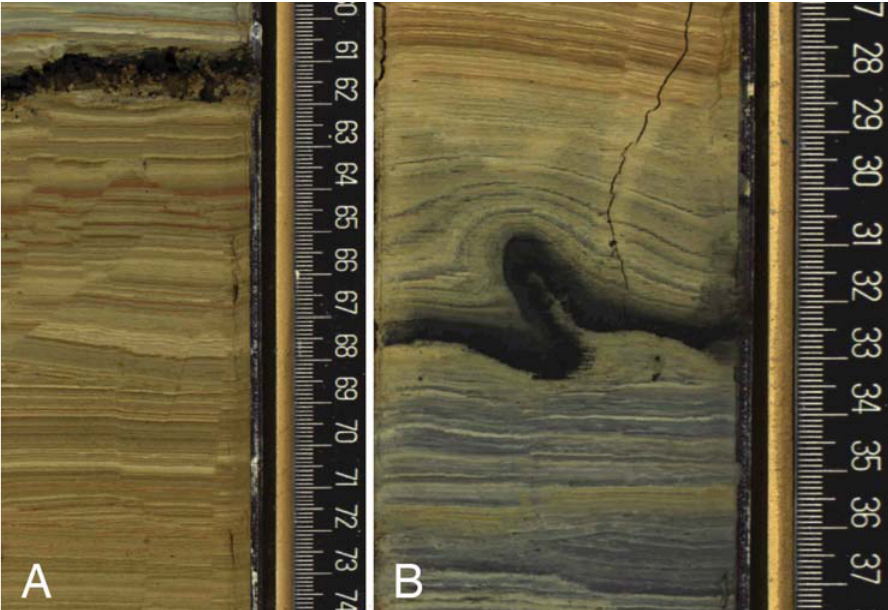
Figure 15. Examples of paleoseismic deformations in the cores. [A] Microfaults dissecting the finely laminated succession. They are only considered of paleoseismic significance if they occur in parallel cores at the same horizons, so that drilling artifacts can be ruled out. [B] Fine tephra layer that has been deformed in a microfold, indicating slumping, potentially induced by seismic shaking.